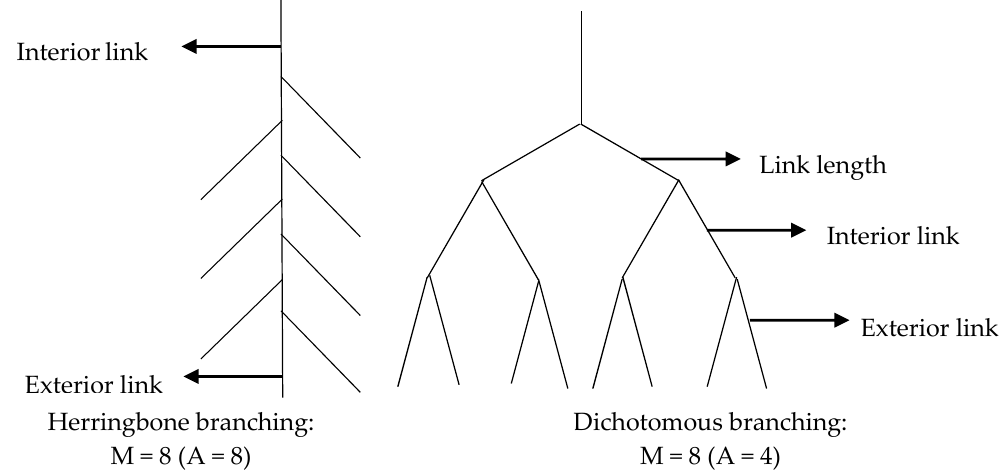
Figure 1. Schematic representation of Fitter’s link-based parameters used to describe root topology. A link is defined as a piece of the root between two branching points (interior link) or between a branch and a meristem (exterior link). The magnitude (M) of the overall root system represents the number of exterior links, which equals the number of meristems in a root. The magnitude of an individual link within the root system represents the total number of root segments connected to the shoot through that specific link. The altitude of the overall root system (A) is the number of links in the longest path from an exterior link to the most basal link of the root system. The topological index of a root system may be defined as log altitude/log magnitude.